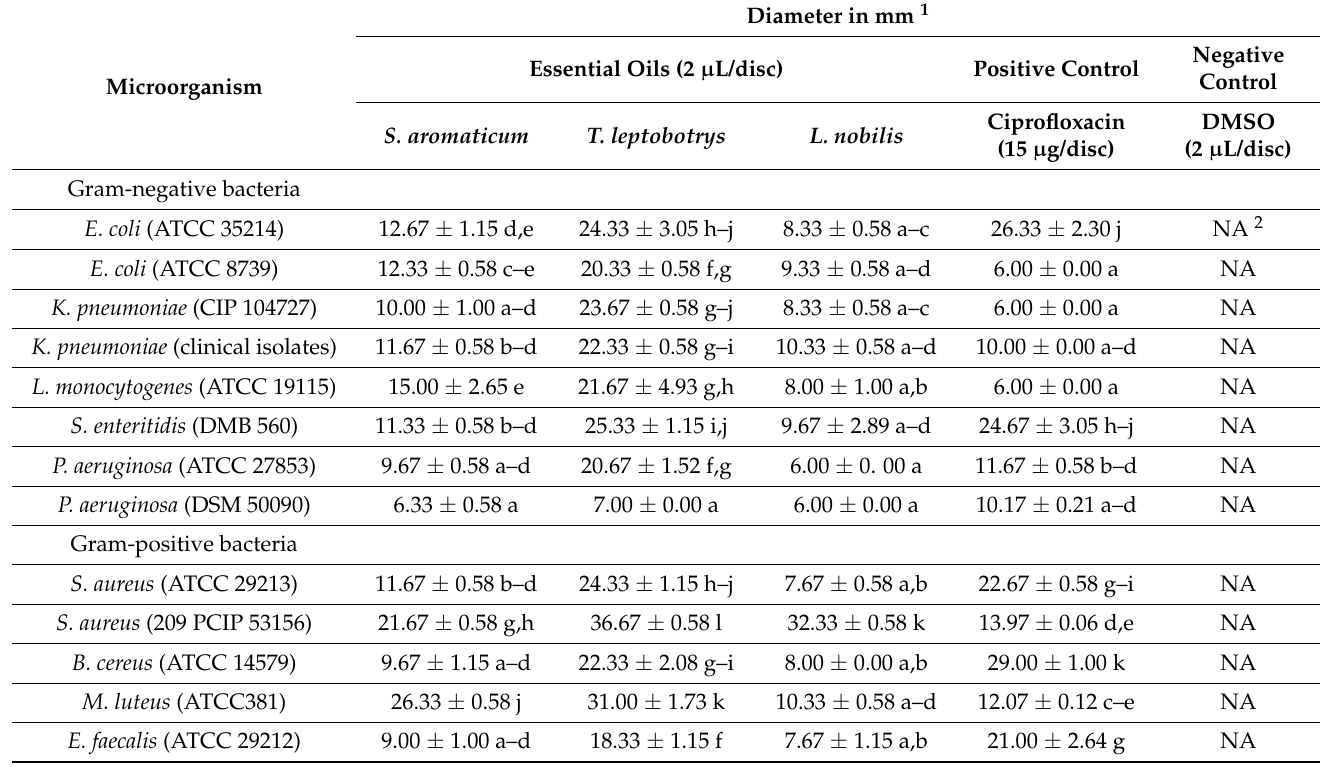
Table 4. Diameter of inhibition zones (mm) of essential oils against bacterial